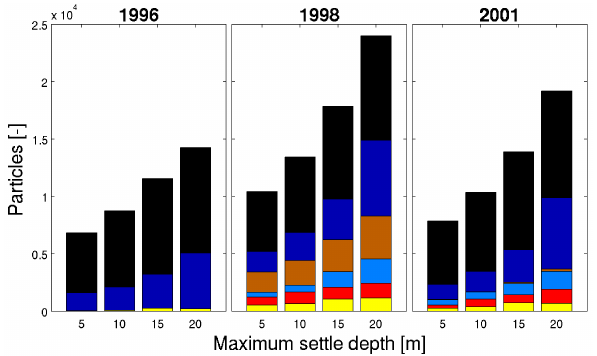
Figure 17. Settlement into the different areas as shown in Fig. 7, for different maximum settle depths for 1996, 1998 and 2001. Only 100000 particles released around 1 January, are taken into consid- eration (similar to Fig. 5).